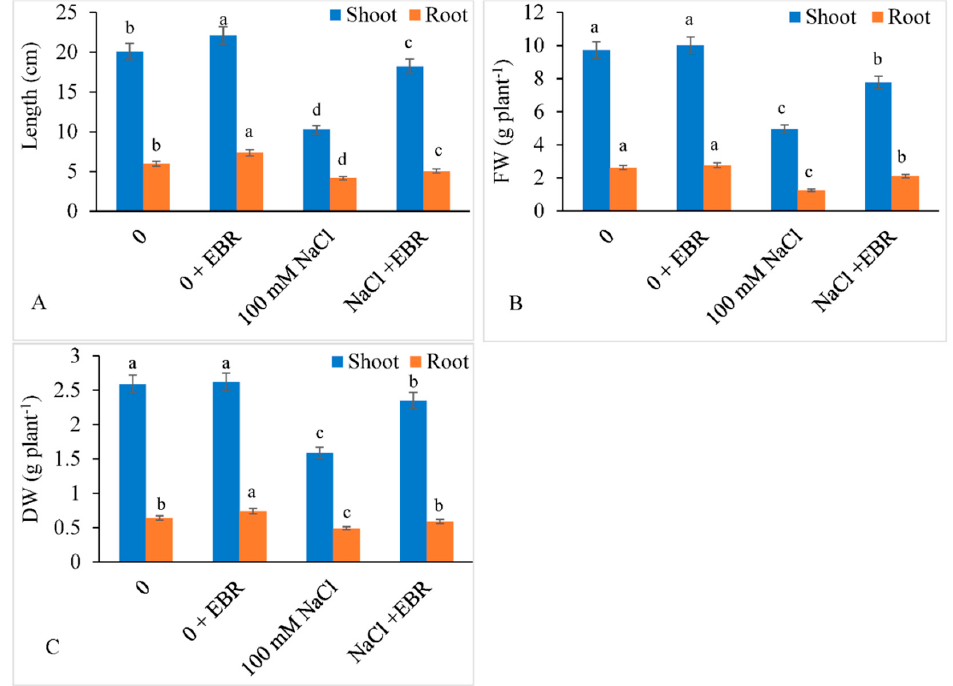
Figure 1. Ameliorating role of 24-epibrassinolide (EBR) on ( A ) length, ( B ) fresh weight, and ( C ) dry weight of shoot and root under NaCl toxicity in soybean. Data presented are the means ± SE ( n = 5) and significant difference calculated between the means at p ≤ 0.05 using the Duncan’s multiple range test.